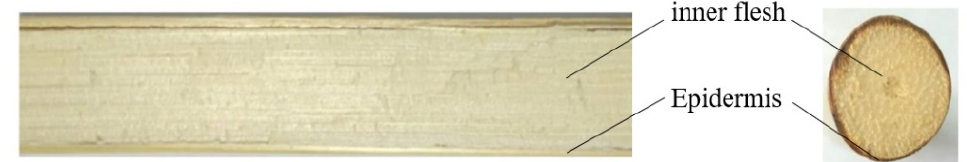
Figure 1. Shape of corn straws.